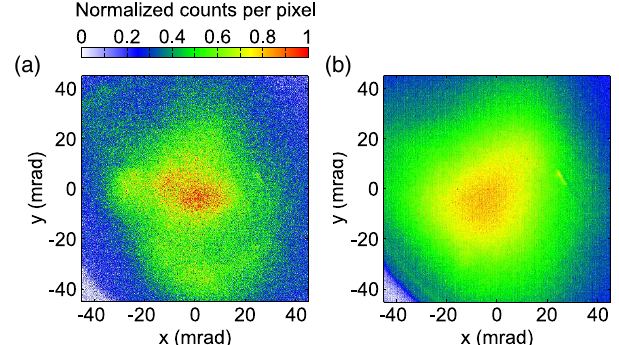
FIG. 3. Electron beam profiles corresponding to case 1. (a) Single-shot image. Divergence — 44 × 57 mrad FWHM (b) 40-shot average, 74 × 75 mrad FWHM. Estimated charge — 2 . 5 pC = shot ( (cid:2) 14% st.